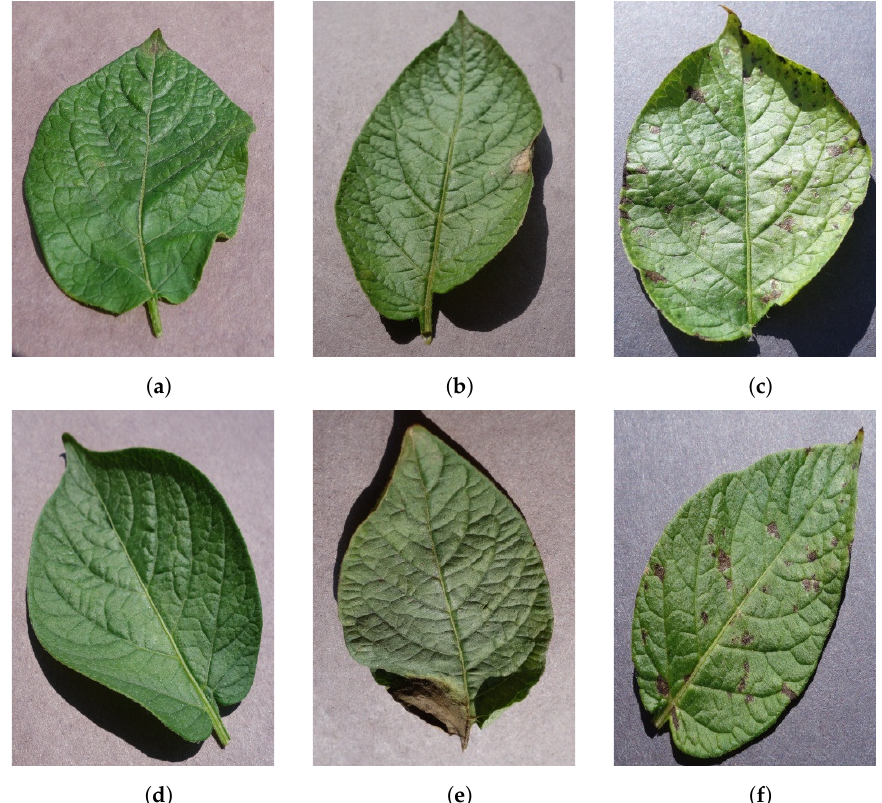
Figure 1. Sample images of potato leaf dataset: ( a , d ) Healthy, ( b , e ) Late Blight, and ( c , f ) Early